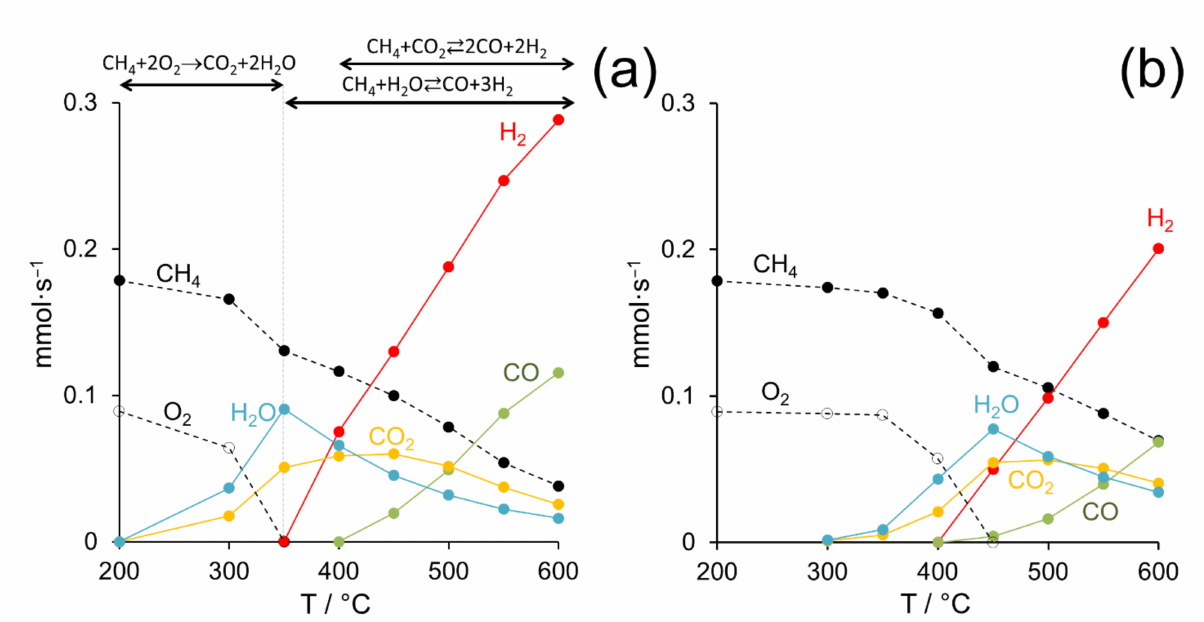
Figure 4. Molar flows of the different species present during the partial oxidation of methane on Pd/CeO 2 (0.5 wt.% Pd) prepared by dry ball milling from palladium acetate and CeO 2 at 50 Hz for 5 min ( a ) and by incipient wetness impregnation of CeO 2 with Pd acetate ( b ). GHSV = 12 × 10 3 h − 1 , F/W = 60 L h − 1 g − 1